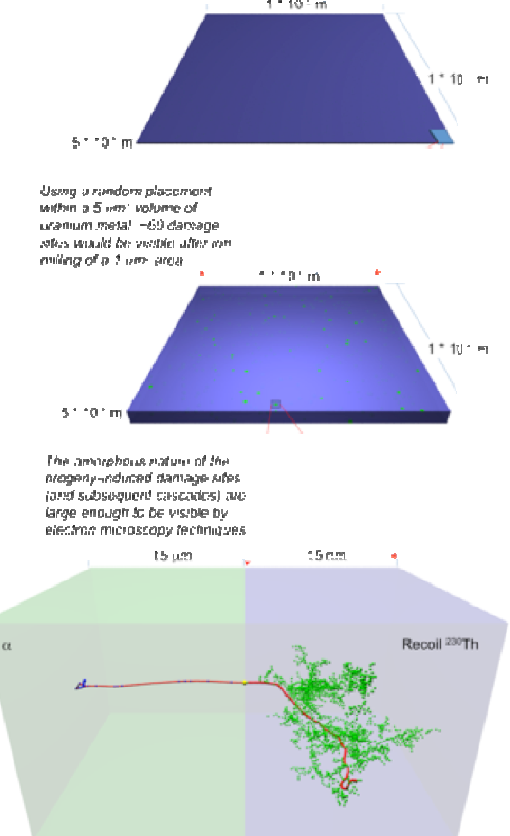
Figure 3. Figure 3. SRIM Trajectories (red) for the 4.8 MeV α -particle (left) and recoil 230 T(right) in uranium metal corresponding to the decay of 234 Uisotope